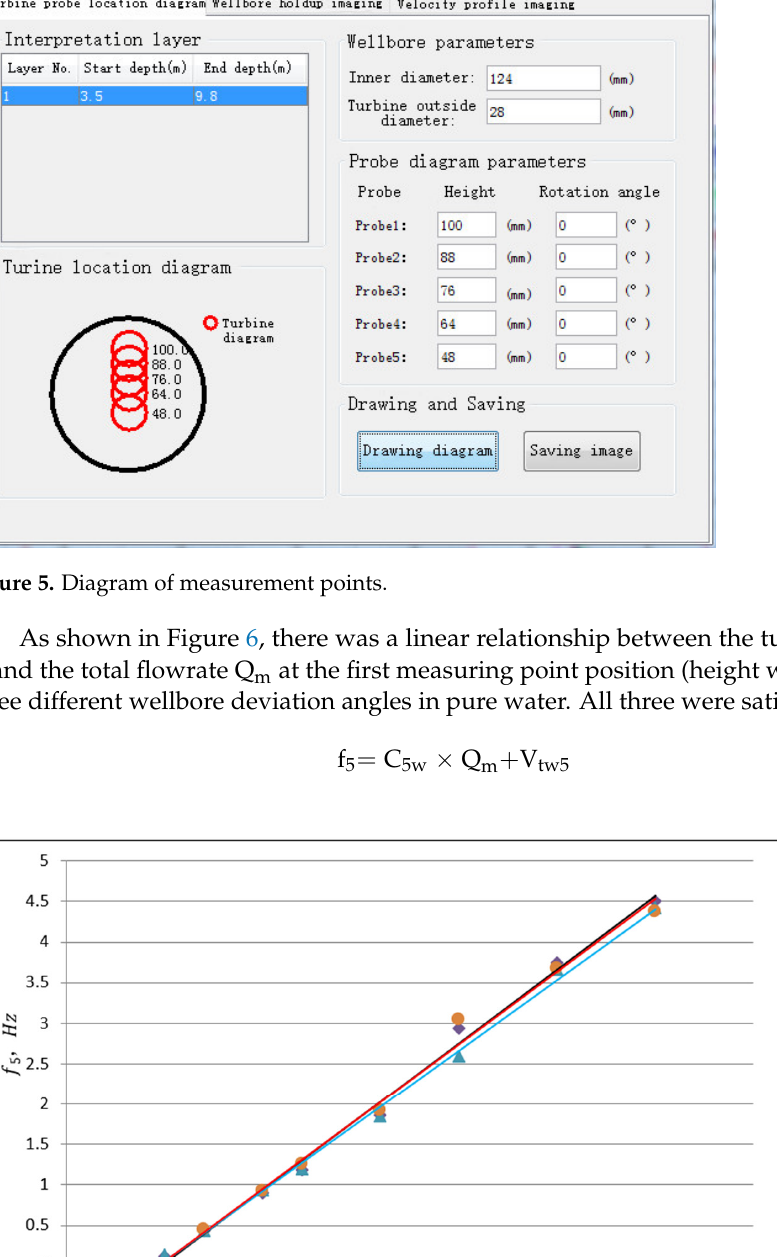
Figure 5. Diagram of measurement points .